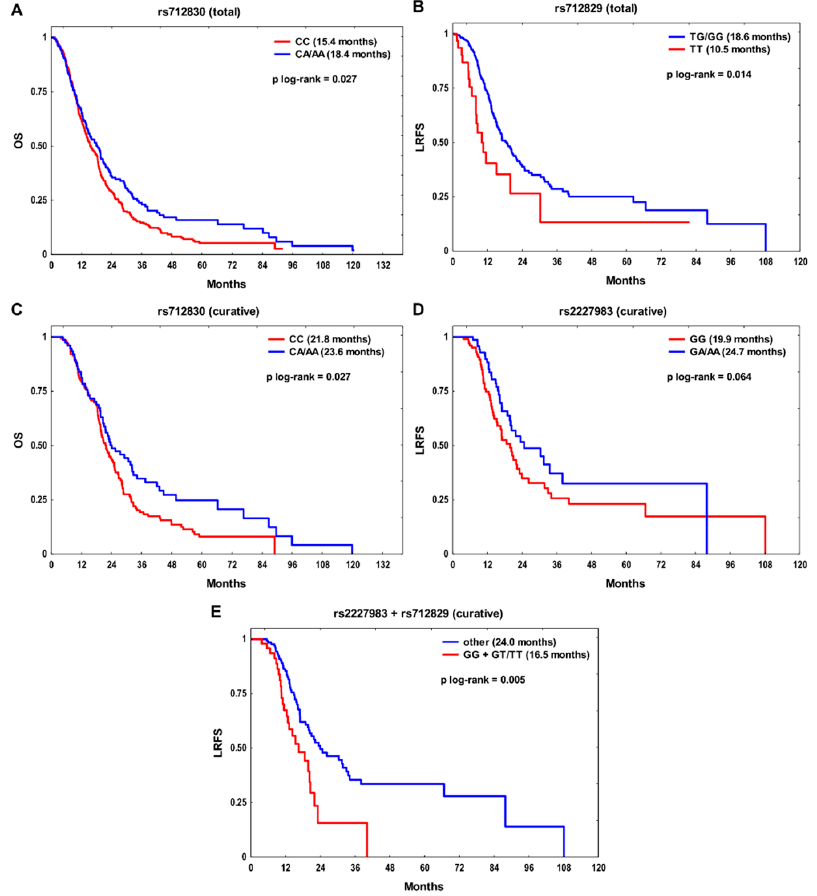
Figure 1. The Kaplan–Meier plots for the effect of ( A ) rs712830 on overall survival (OS) and ( B ) rs712829 on locoregional recurrence-free survival (LRFS) in the whole group, and ( C ) rs712830 on OS, ( D ) rs2227983 on LRFS and ( E ) rs2227983/rs712829 combination on LRFS in the curative treatment subgroup. Median survival time is shown in the brackets. Table 2. Survival analysis according to individual SNPs in the whole group.